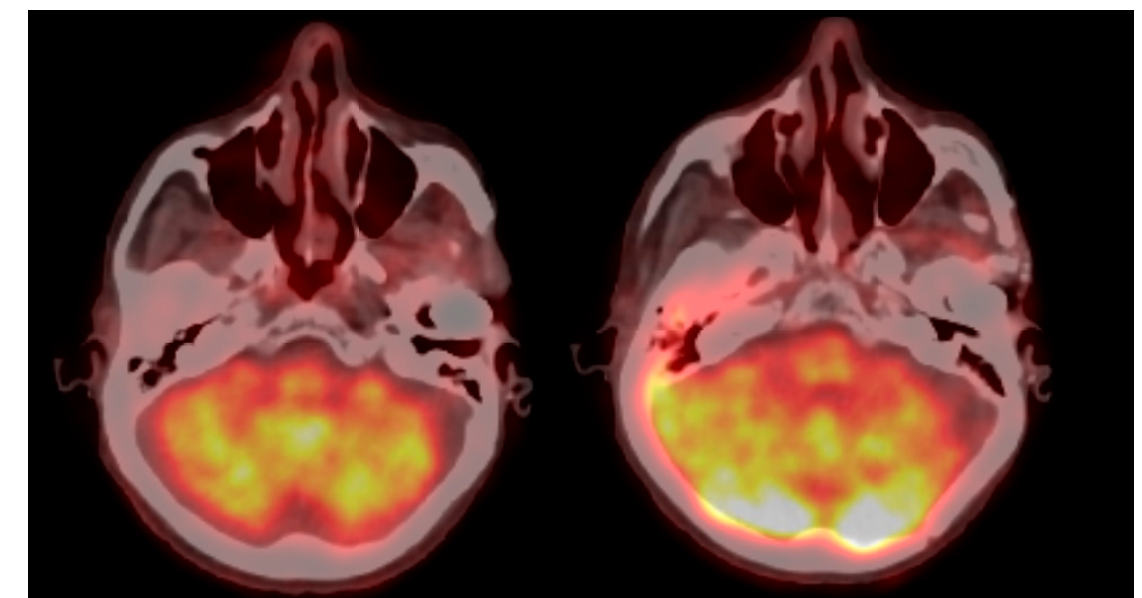
Figure 7. Radiotherapy planning.